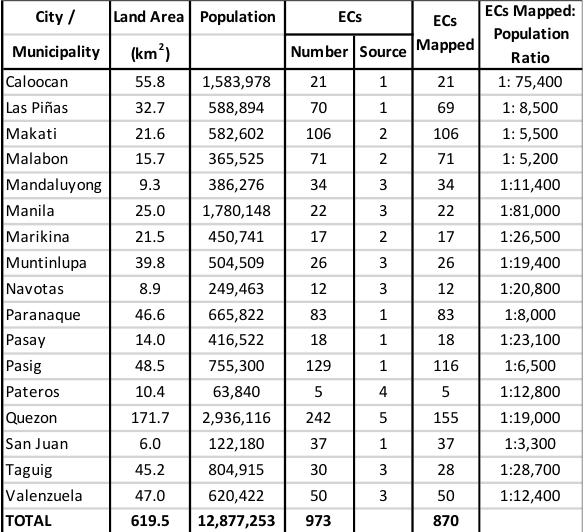
Table 1. Land area, population, evacuation centers (ECs), and ECs-to-population ratio per city/municipality in Metro Manila. Land area and population data are from the Philippine Statistics Authority (2015). Figure 2. Distribution of evacuation centers in Metro Manila. Table 1 lists the data